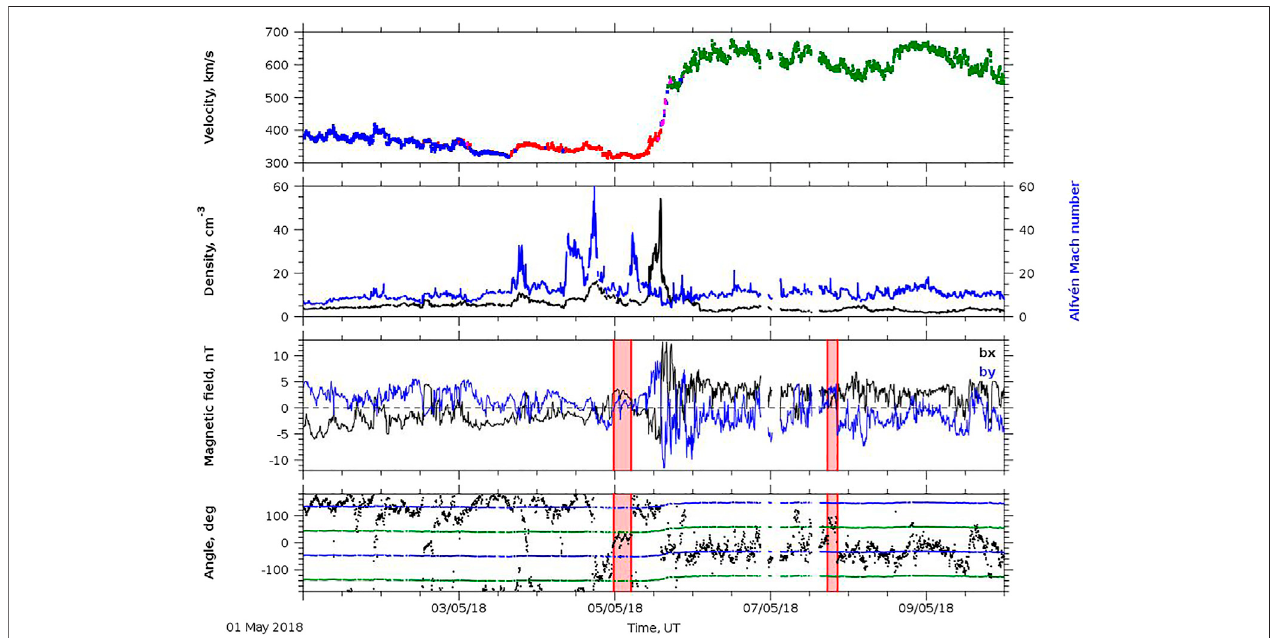
FIGURE2| 9 days ofsolarwindinMay2018observedatL1. Thetoppanelshowsthewind velocitycoloredbytheplasmaoriginscharacterizedby Eqs3 – 5 :SRR (red), SBO(blue), CHO (green), and ejecta (magenta).Thesecondpanel shows thedensity, whichpeaks at the “ ejecta ” eventseen inmagentaonthe fi rst panel, and the Alfvén Mach number (in blue) which shows high values for SRR plasmas. The magnetic fi eld components bx (black) and by (blue) in GSE are plotted on the third panel. Thedottedvaluesonthefourthpanelis Φ B ( Eq.2 ,theobservedorientationofthemagnetic fi eld),theupperbluelinecorrespondsto Φ P ( Eq.1 ,thecommonParker spiral orientation), the bottom blue line to Φ P -180 ° (the so-called anti-Parker orientation), the upper green line to Φ P -90 ° (ortho-Parker orientation), and the bottom green line to Φ P -270 ° (ortho-Parker orientation). Two examples of prolonged intervals (several hours) of ortho-Parker orientations are shaded red in between thick vertical red lines.